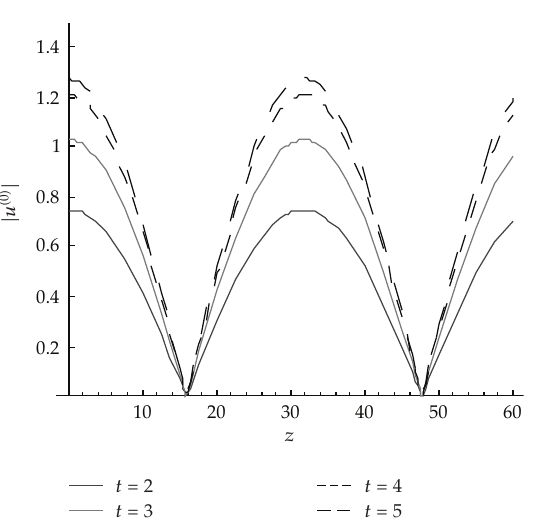
Figure 33: The zero-order approximation | u (cid:3) 0 (cid:4) | at α (cid:8) 1, T (cid:8) 10, γ (cid:8) 0 for di ff erent values of t , considering only one term in the series (cid:3) M (cid:8) 1 (cid:4) .